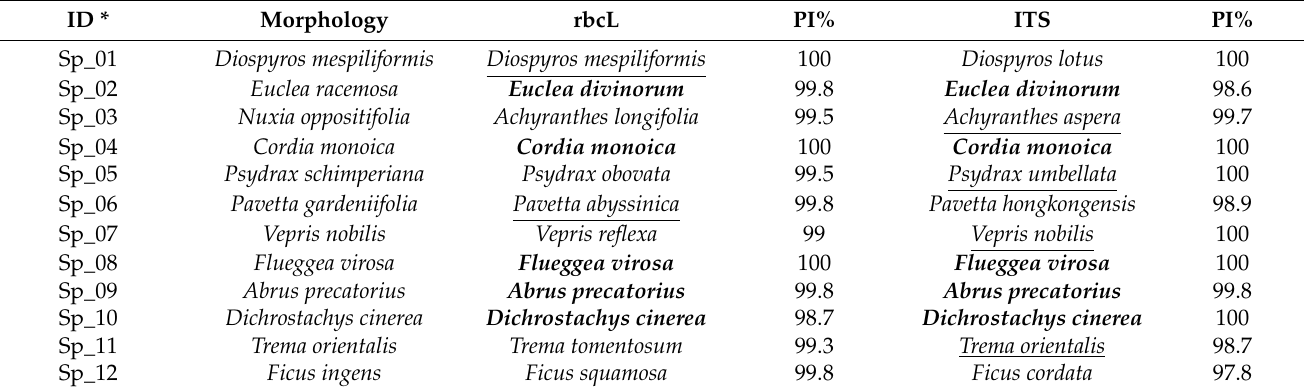
Table 3. Comparative identification summary based on the morphological inspection, rbcL, and ITS DNA barcodes of twelve rare plants of the Faifa